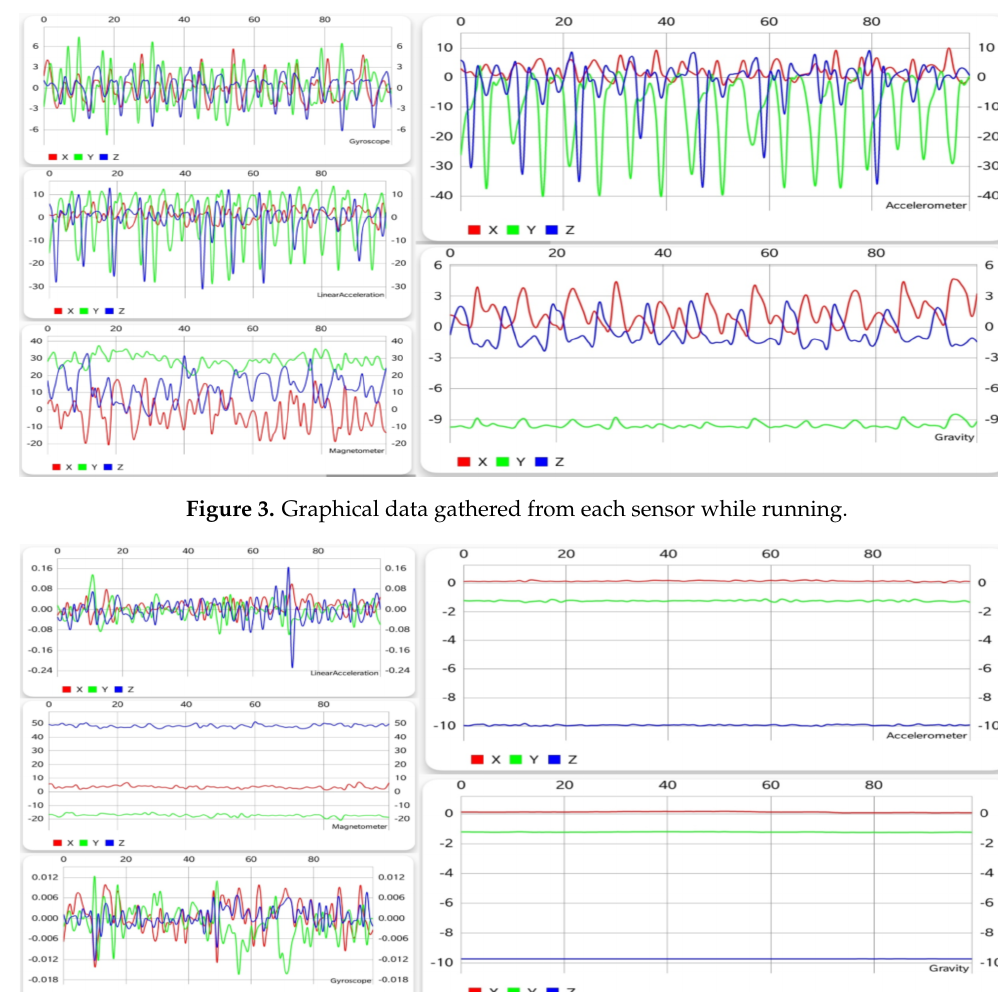
Figure 4. Graphical data gathered from each sensor while